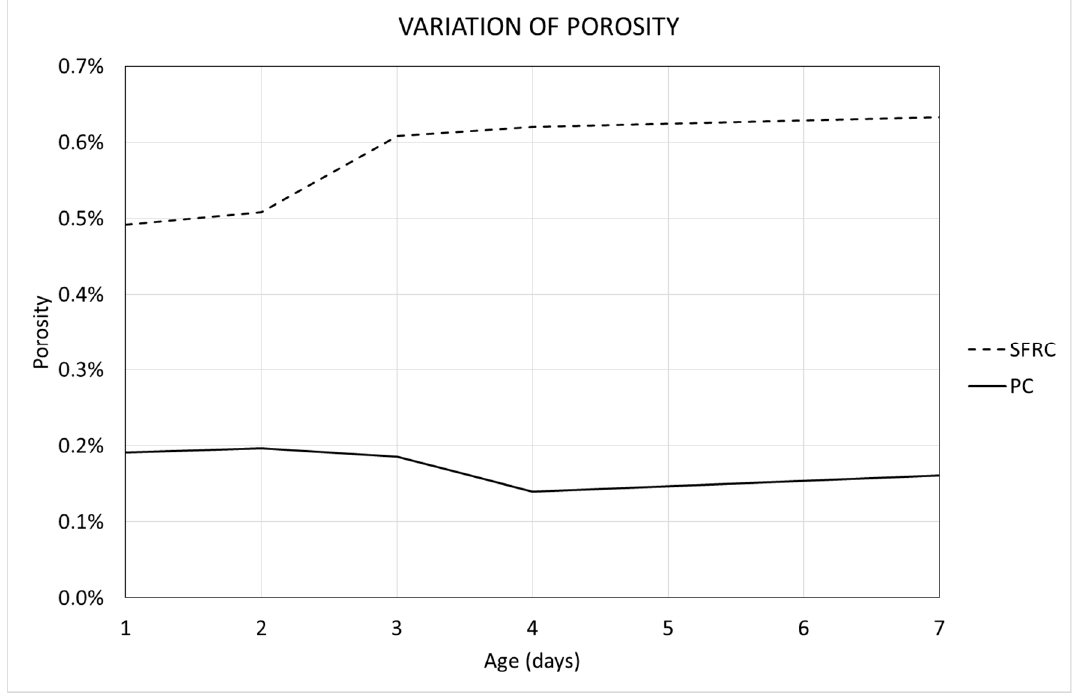
Figure 9. Variation of the porosity with the age of concrete.